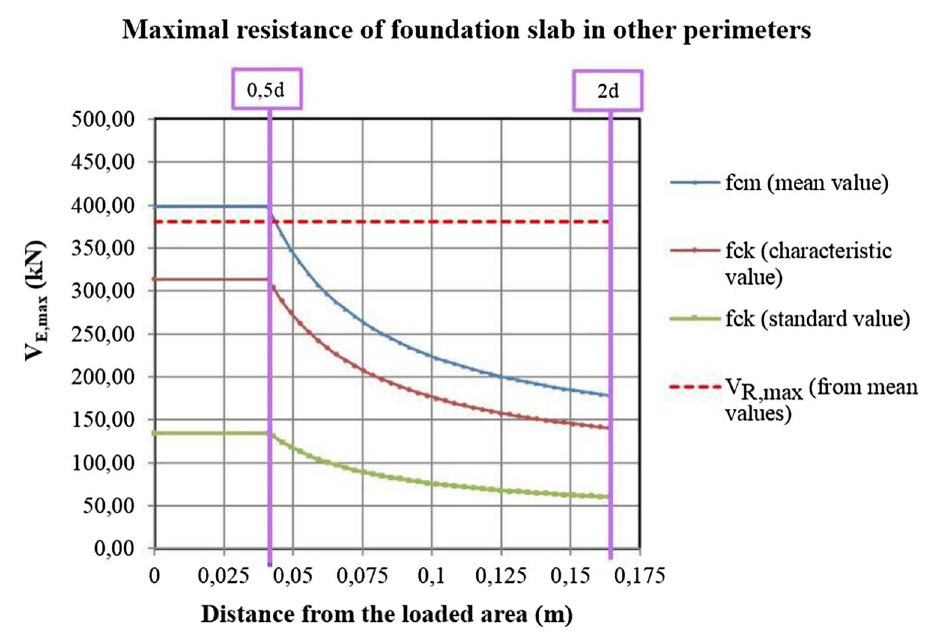
Fig. 10 Maximum punching shear force according to